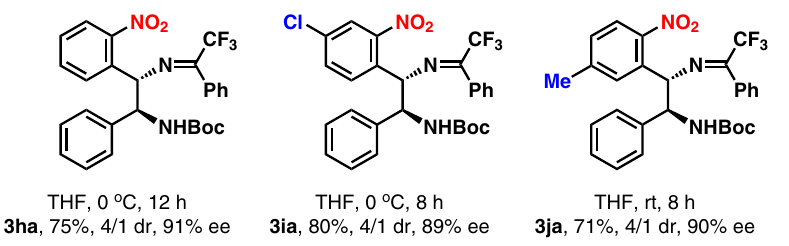
Fig. 3 Substrate scope of ketimines 1 a . Ketimines derived from both 4-nitro-benzylamines and 2-nitro-benzylamines are employed. a 1b-1j: 0.2 mmol, 2a: 0.3 mmol. Isolated yield. Dr determined by 1 H NMR analysis of the crude reaction mixture. Enantioselectivity determined by chiral-stationary-phase HPLC analysis.